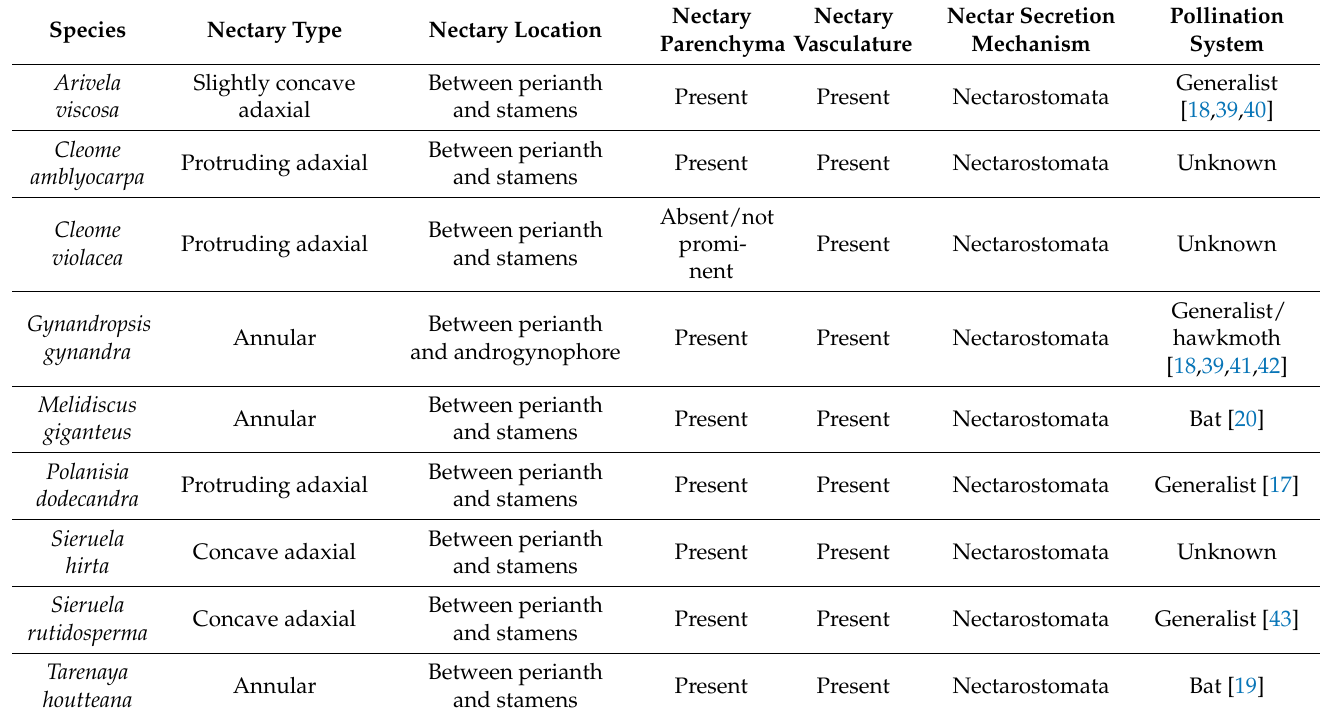
Table 1. Summary of floral nectary characteristics and pollination system for the nine Cleomaceae species.